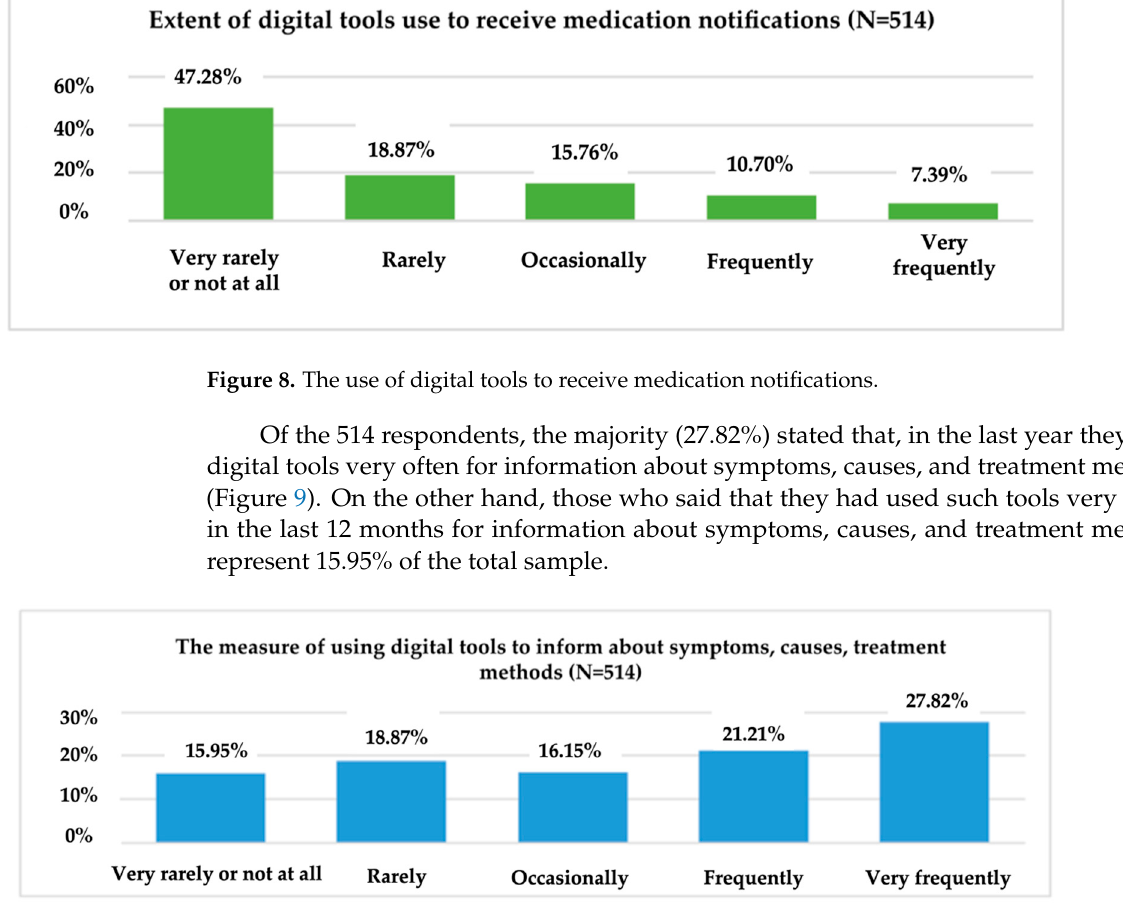
Figure 9. The use of digital tools for information about symptoms, causes, treatment methods.